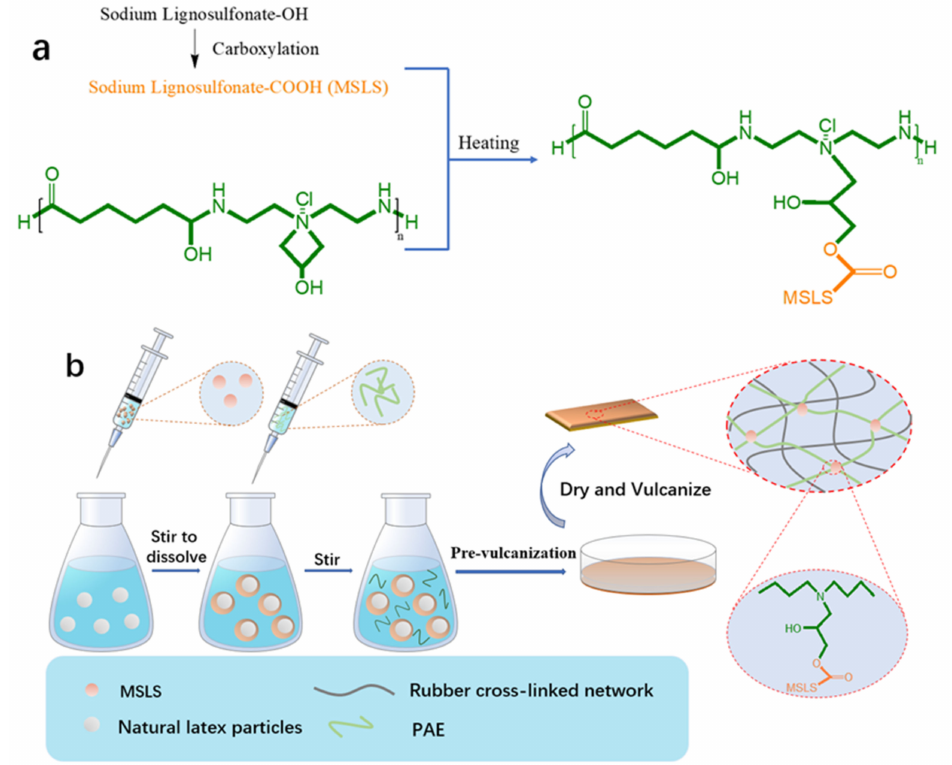
Figure 1. ( a ) Potential MSLS-PAE crosslinking mechanism, and ( b ) schematic illustration for MSLS- PAE/NRL double network